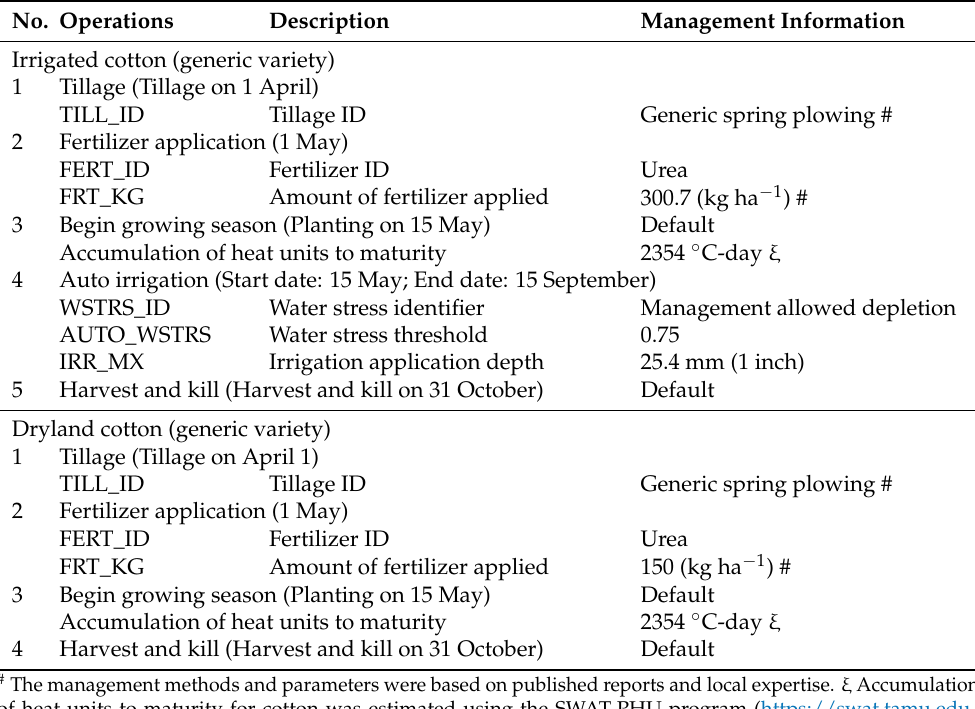
Table 2. Management practices for irrigated and dryland cotton production under the baseline scenario in the Double Mountain Fork Brazos basin.